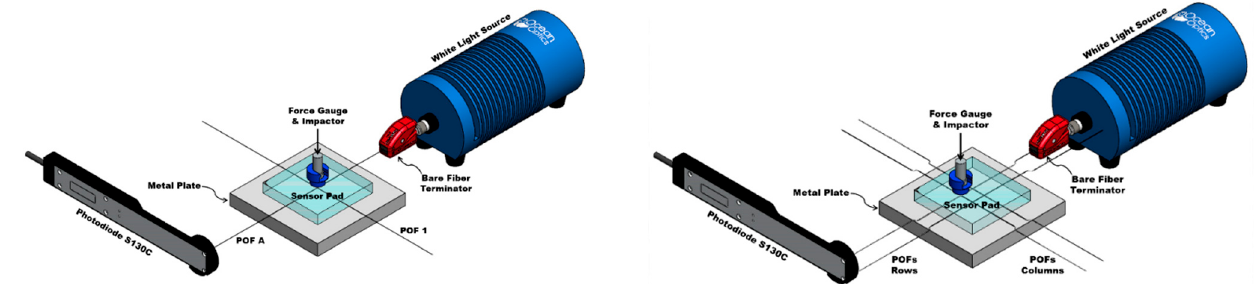
Figure 5. Three ‐ dimensional representation of the experimental setups used to expose the 1 POF × 1 POF ( left ) and 2 POFs × 2 POFs ( right ) samples to the pressures selected with the scientific equipment.